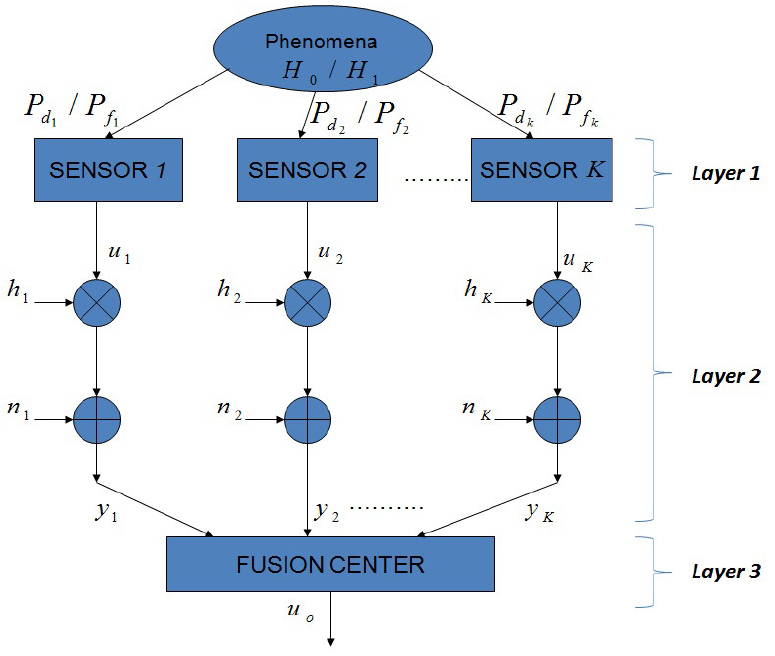
Figure 1. Traditional three-layer parallel WSN system model